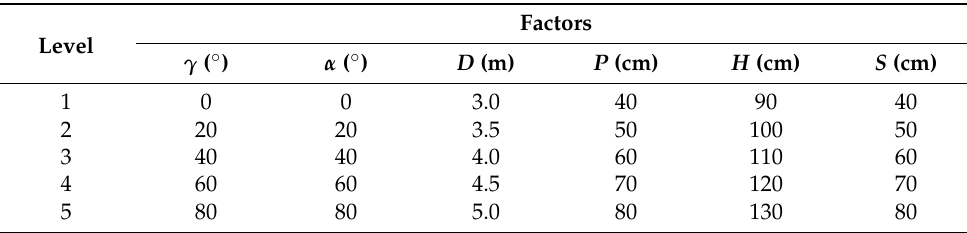
Table 4. The influencing factors and level of the massive integrity structure rock mass.